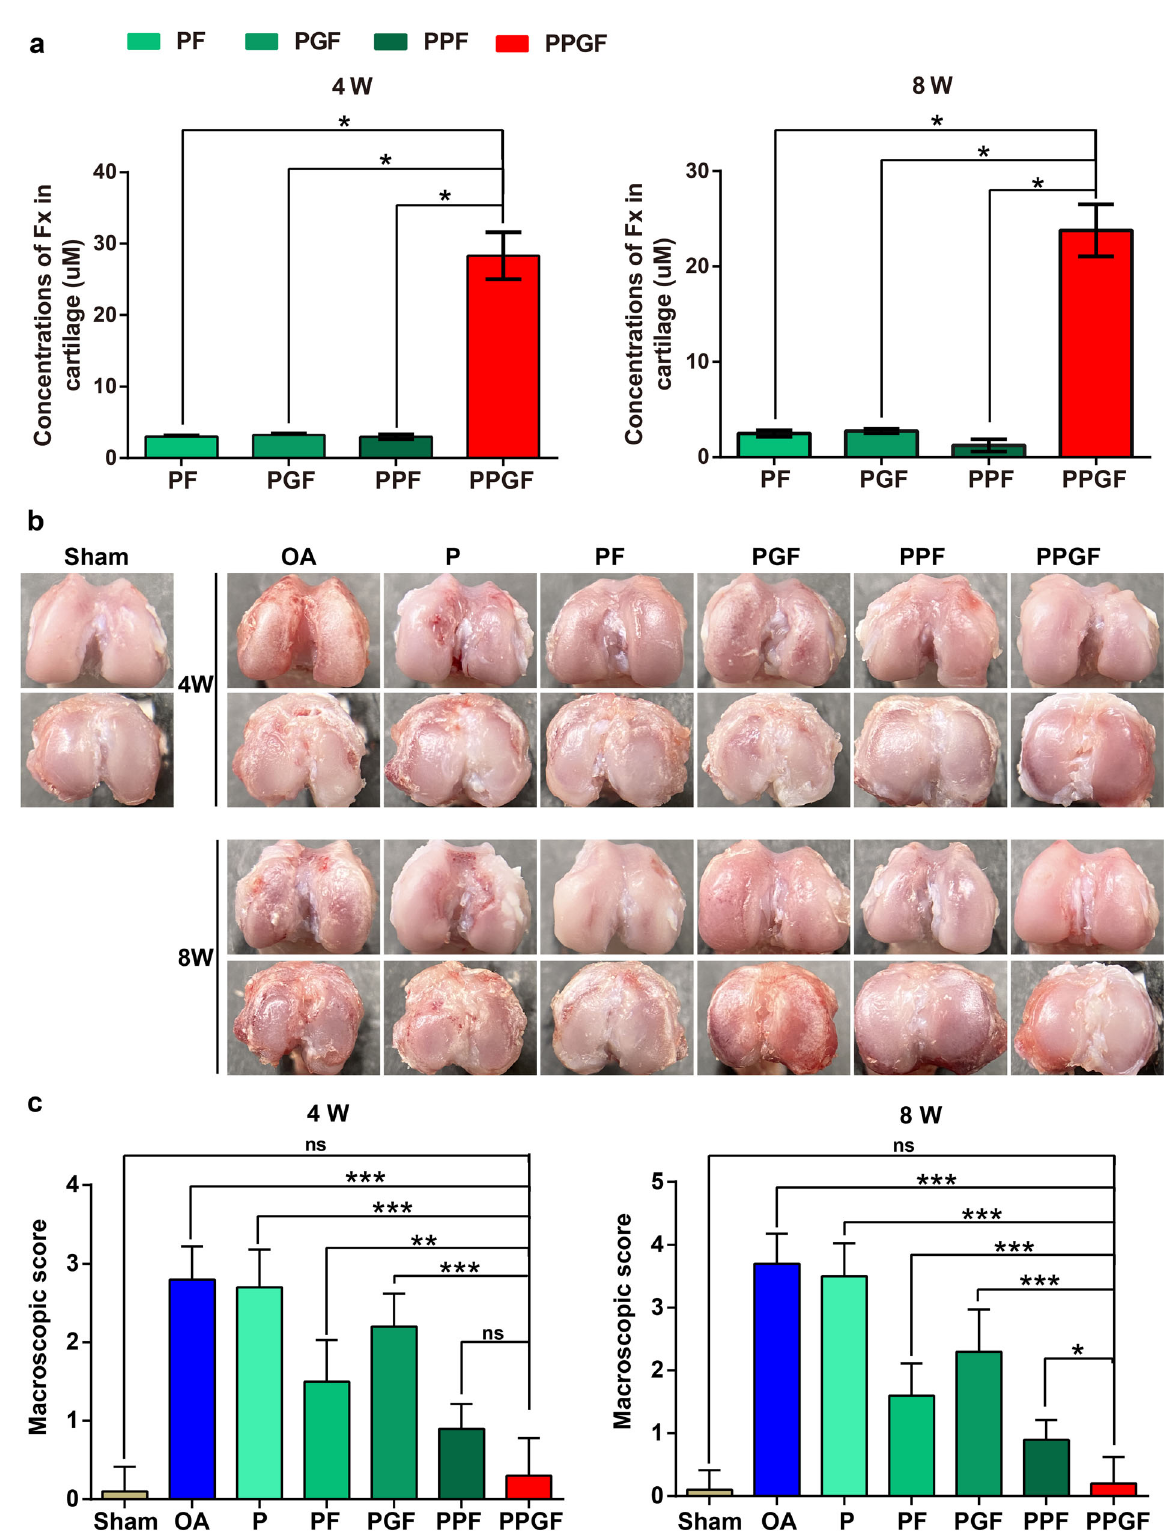
Fig. 8 Macroscopic evaluation of articular treated by nano fi ber membranes. a The concentration of Fx in the cartilage after implantation of the nano fi ber membranes for 4 and 8 weeks. b Macroscopic appearance and c score of articular from the distal femur and tibial plateau after treatment by nano fi ber membranes for 4 and 8 weeks. The values were presented as mean ± SD ( n = 5; statistics: one-way ANOVA; ns means p > 0.05, * means p < 0.05, ** means p < 0.01, *** means p <